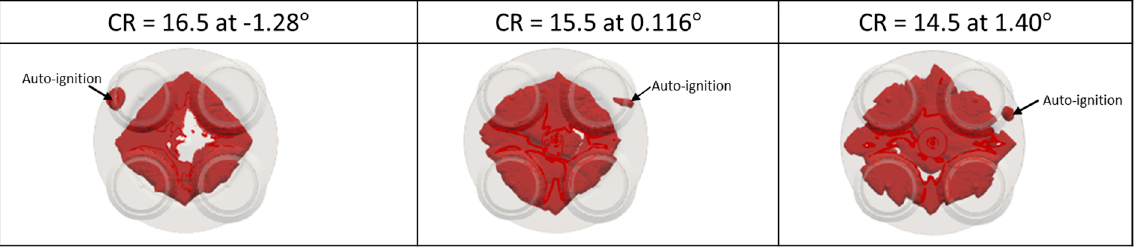
Figure 9. Comparison of iso-surface of temperature for λ = 2.85 and ST = − 5 CAD at different CRs.